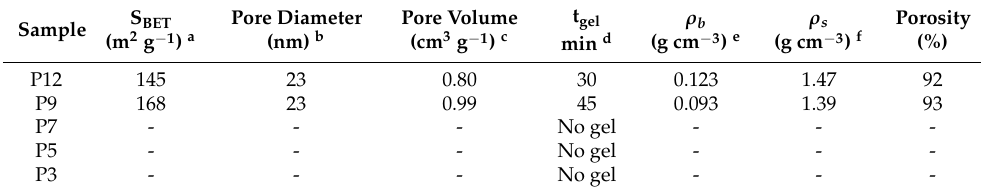
Table 1. Textural properties of the PVDF aerogels.